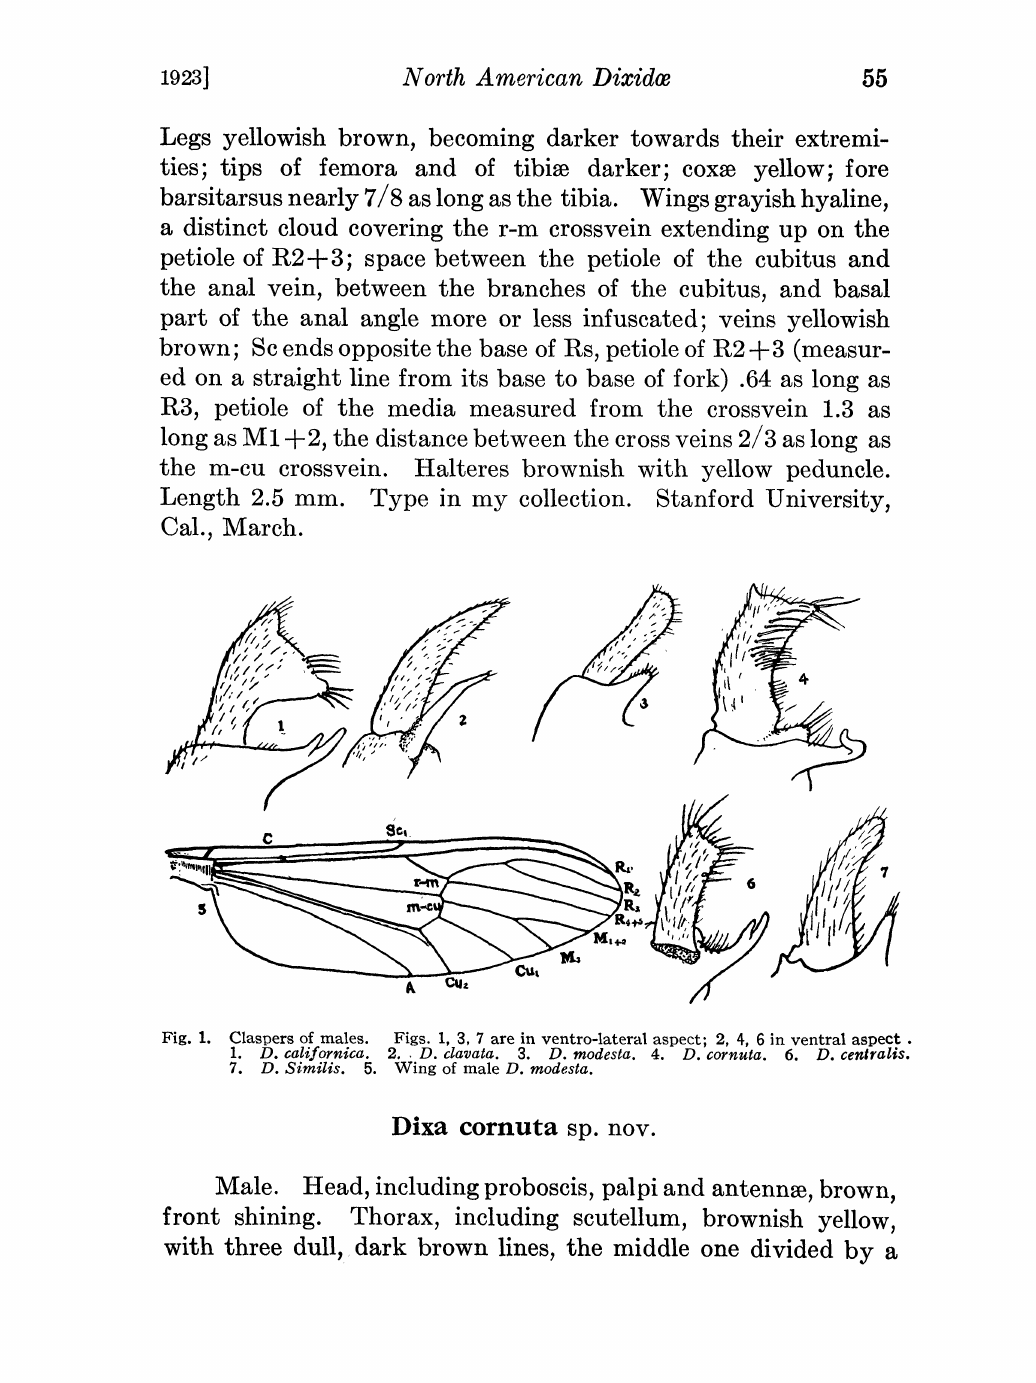
Fig. 1. Claspers of males. Figs. 1, 3, are in ventro-lateral aspect; 2, 4, 6 in ventral aspect. 1. D. californica. 2.. D. davata. 3. D. modesta. 4. D. cornuta. O. D. cenlralis. 7. D. Similis. 5. Wing of male D. modesta. Dixa cornuta sp.